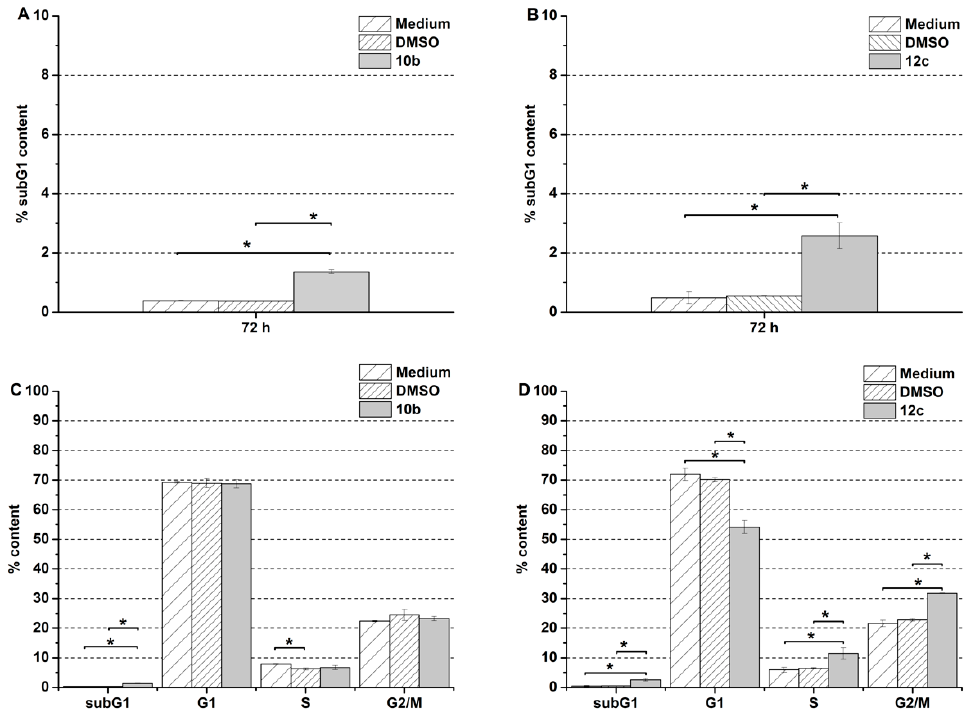
Figure 3. Effects of 10b and 12c on the cell cycle progression of PANC-1 cells. The model cell was treated with the compounds at their IC 50 concentration for 24 h. Results are expressed as a percentage of cells in the subG1 phase (( A )— 10b and ( B )— 12c ) and the major phases (G1 / G0, S and G2 / M) of the cell cycle (( C )— 10b and ( D) — 12c ). Data shown in the figure represent mathematical averages of two parallel measurements.